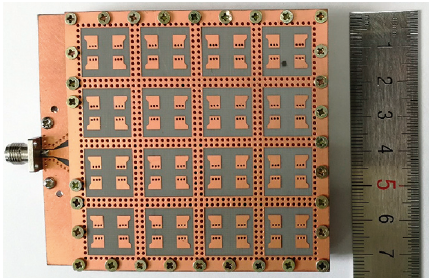
Figure 17: Photograph of the fabricated 4 × 4 ME dipole antenna